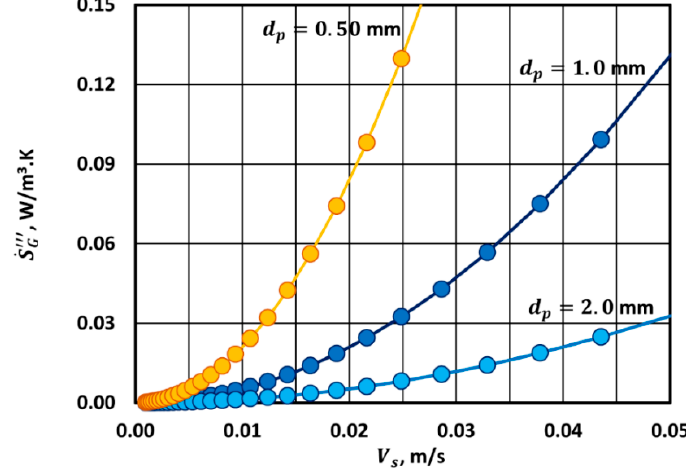
Figure 12. Effect of particle diameter on the rate of entropy generation per unit volume of the packed bed in laminar flow ( T = 298.15 K, ε = 0.40, µ = 18.5 µ Pa · s, ρ = 1.184 kg / m 3 ). The data points are generated using Equation (50).